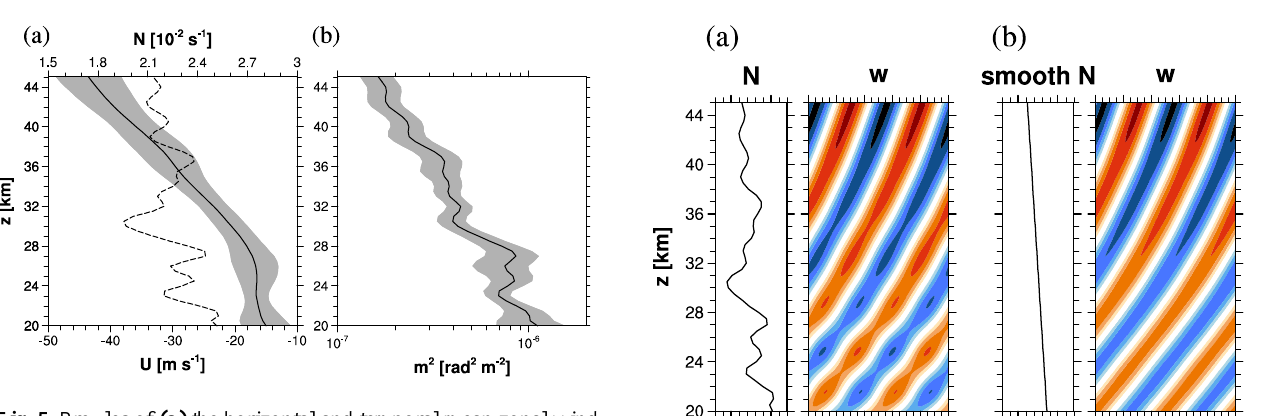
Figure 5. Profiles of (a) the horizontal and temporal mean zonal wind (solid) and Brunt–V¨ais¨al¨a frequency (dashed) and (b) corresponding squared vertical wavenumber for purely eastward propagating waves at a phase speed of 10 m s − 1 (solid). Shading indicates ranges within one standard deviation of the background zonal winds in (a) and of the squared vertical wavenumbers in (b) from their means. Figure 6. x – z cross sections of the vertical wind perturbations obtained from the Taylor–Goldstein equation for the dominant eastward propagating wave with the horizontal wavelength of 500 km at a phase speed of 10 m s − 1 for the profiles of the Brunt–V¨ais¨al¨a frequency (a) without and (b) with smoothing. The perturbations are normalized by the amplitude of the upward propagating waves at 20 km and by the square root of the basic density, and the interval in shading is 0.3. The profiles of the Brunt–V¨ais¨al¨a frequency used are also plotted in the left of each cross section.